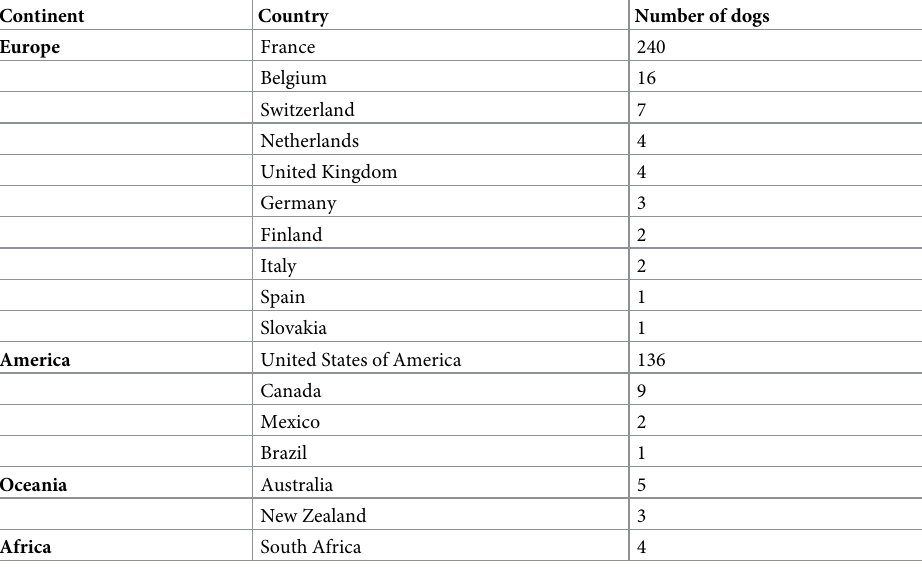
Table 1. List of countries and corresponding number of dogs.